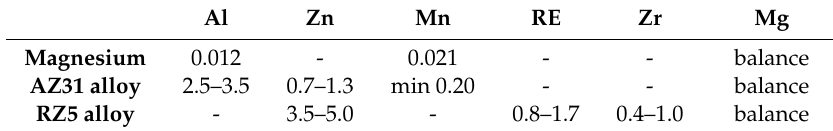
Table 1. Chemical composition of applied matrix alloys, wt.% [34].